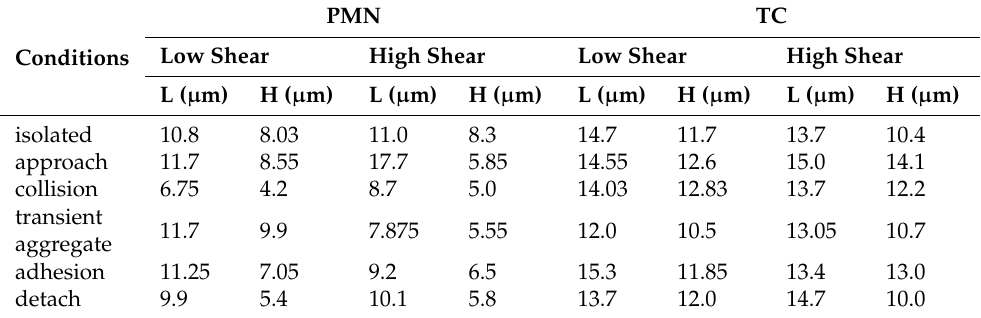
Table 2. Cell dimensions measured in sFn